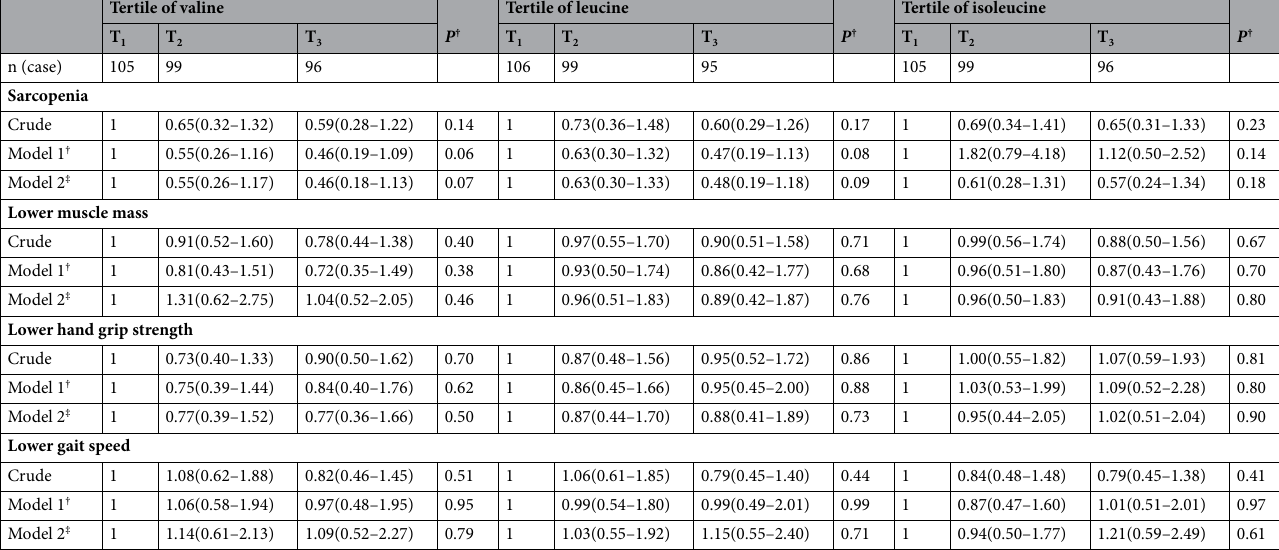
Table 7. Crude and multivariable-adjusted ORs and 95% CIs for sarcopenia and its components across categories of valine, leucine and isoleucine intake. Data are OR (95% CI). † Model 1: Adjusted for age, sex and energy intake. ‡ Model 2: Further adjusted for physical activity, smoking, alcohol consumption, medication use (statin, corticosteroid, estrogen, testosterone), and positive history of disease. † Muscle mass lower than 5.5 (kg/ m 2 ) for women and 7.0 (kg/m 2 ) for men 27 . ‡ Lower muscle strength was defined according previous study 32 . § Gait speeds equal or slower than 0.8 m/s 27